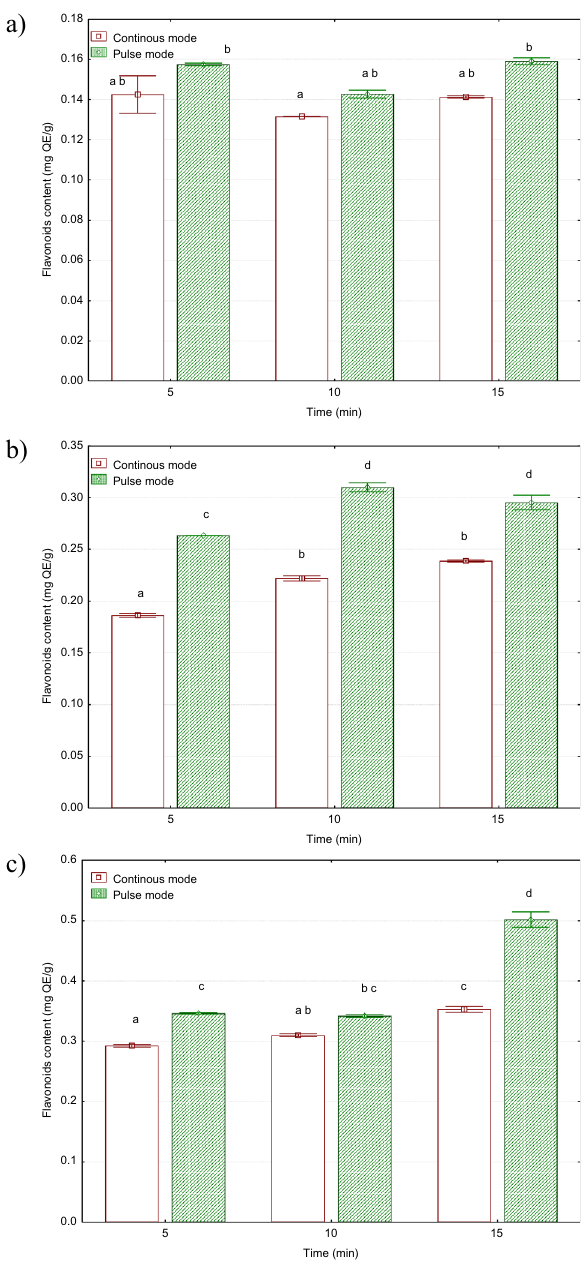
Figure 1. Effect of ultrasonic treatment parameters on the content of flavonoids (mg QE/g d.m.) in Sorbus intermedia berries extracts: ( a ) 12 µm, ( b ) 24 µm ( c ) 36